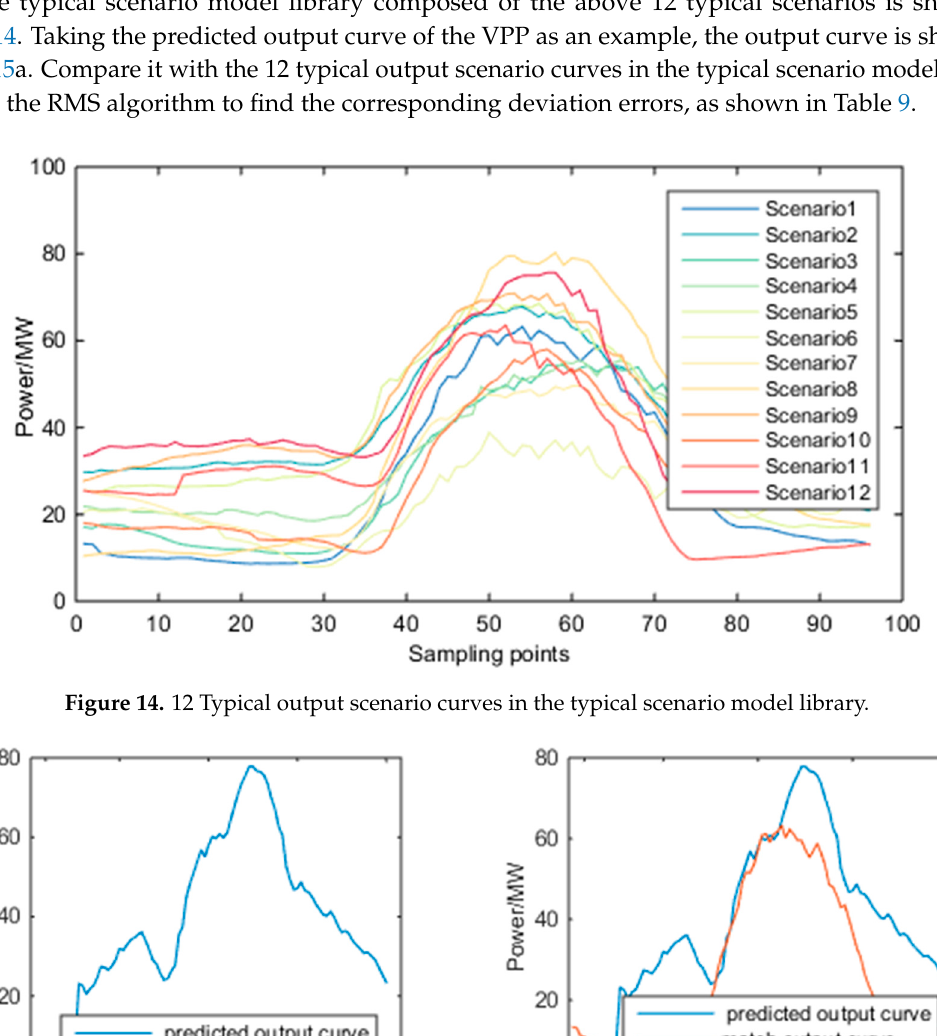
Figure 14. 12 Typical output scenario curves in the typical scenario model library. Table 9. Virtual power plant initial return and optimal return.